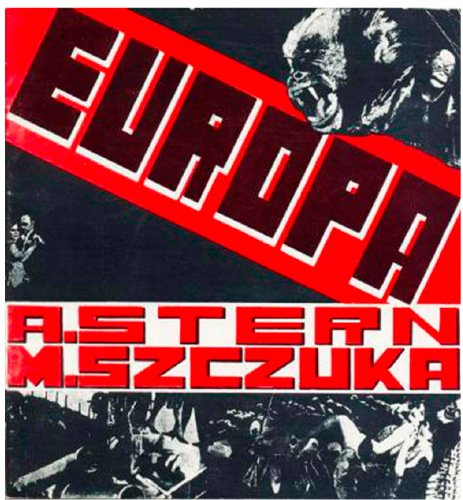
Figure 4. Teresa Ż arnower. Cover design for poem Europa by Anatol Stern, 1929, Muzeum Sztuki in Ł ód ź , Figure 4. Teresa ˙Zarnower. Cover design for poem Europa by Anatol Stern, 1929, Muzeum Sztuki in public domain image. Ł ó d´z, public domain